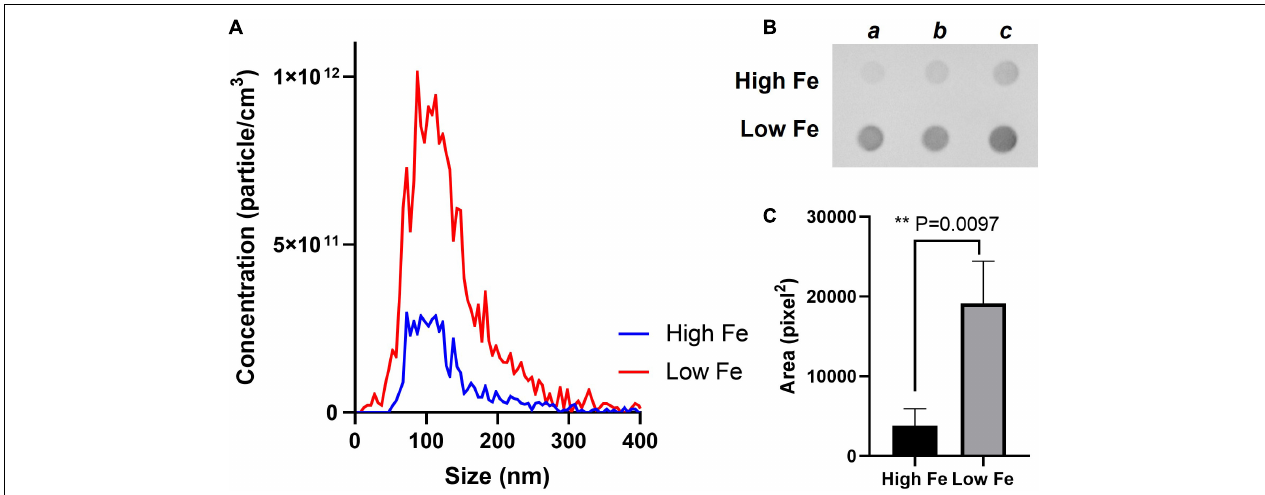
FIGURE 1 | Fe starvation induces vesicle production in Mtb . (A) MEVs purified from High and Low Fe cultures using sucrose gradient centrifugation and submitted to nanoparticle tracking analysis using ZetaView. Graph shows size distribution (nm) and corresponding to particle concentration (particle cm - 3 ). (B) Dot blot analysis of the indicated MEV preparation from three independent cultures (a, b, c) using a specific antibody against MEVs. (C) The area (pixel 2 ) of the spots calculated in ImageJ as previously described (Ziegenbalg et al., 2013). Graph shows mean values and standard deviation. Results are considered to be statistically significant when P < 0.05 according to an unpaired two-tailed t